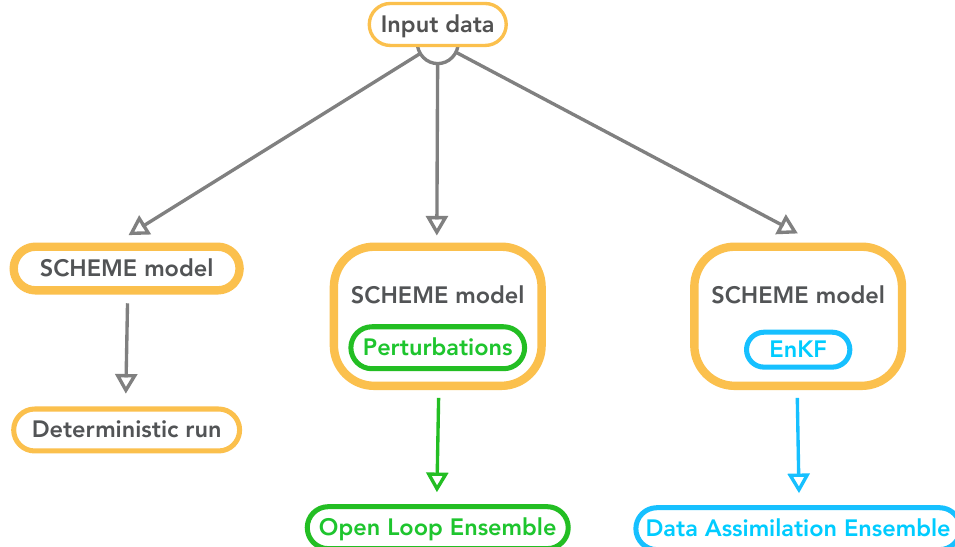
Figure 7. The three types of experiments performed with the SCHEME